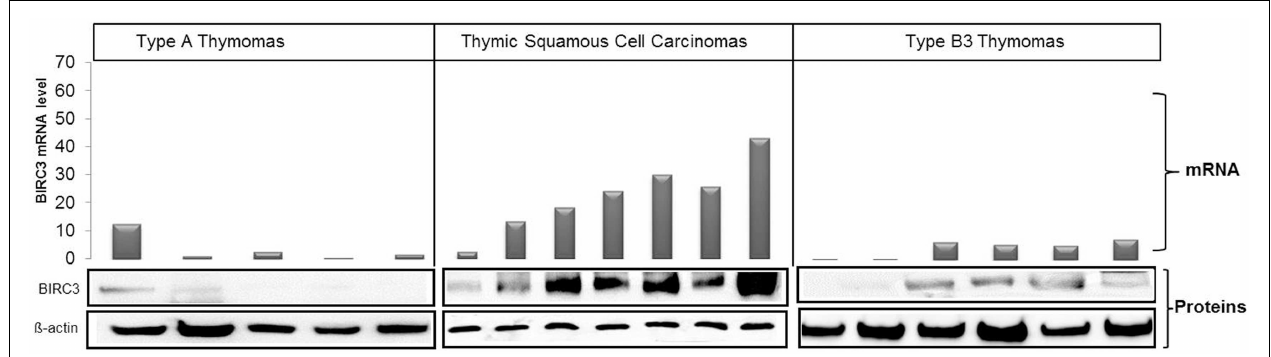
FIGURE 4 | Correlation between BIRC3 mRNA and protein levels in typeA (five cases) and type B3 (six cases) thymomas andTSCC (seven cases) . Levels of mRNA and protein were higher inTSCCs than in thymomas. mRNA was quantified using real time PCR with GPDH as reference, β -actin was used as loading control in western